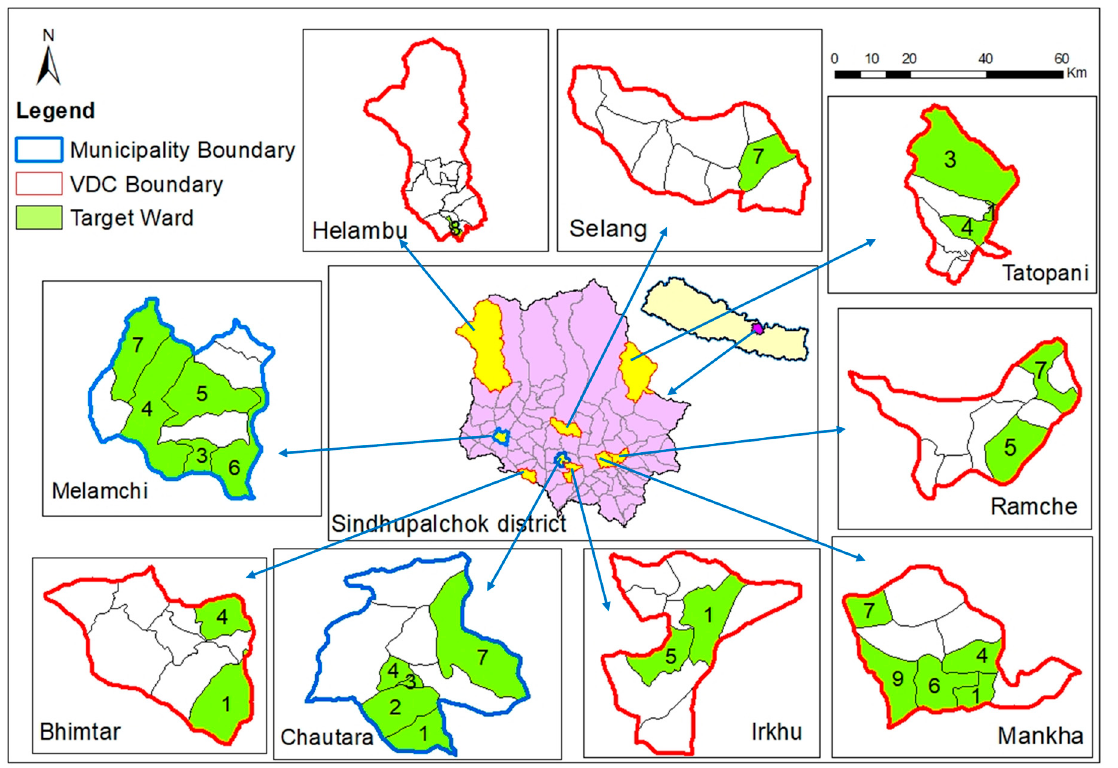
Figure 1. Wards of the municipalities and village development committees (VDCs) selected for sampling in Sindhupalchowk district.